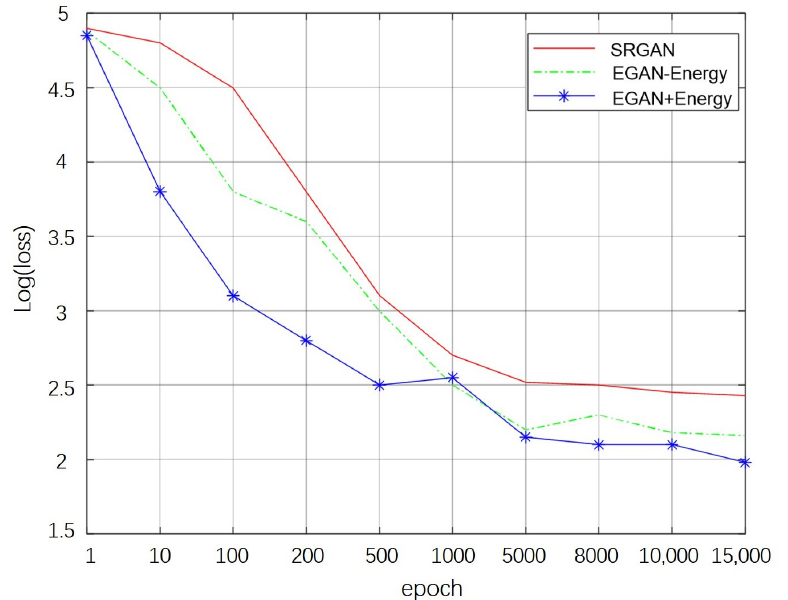
Figure 6. Convergence analysis on the loss functions between SRGAN and EGAN. Our loss func- tion with energy-based regularization shows powerful performance, as well as a relatively fast